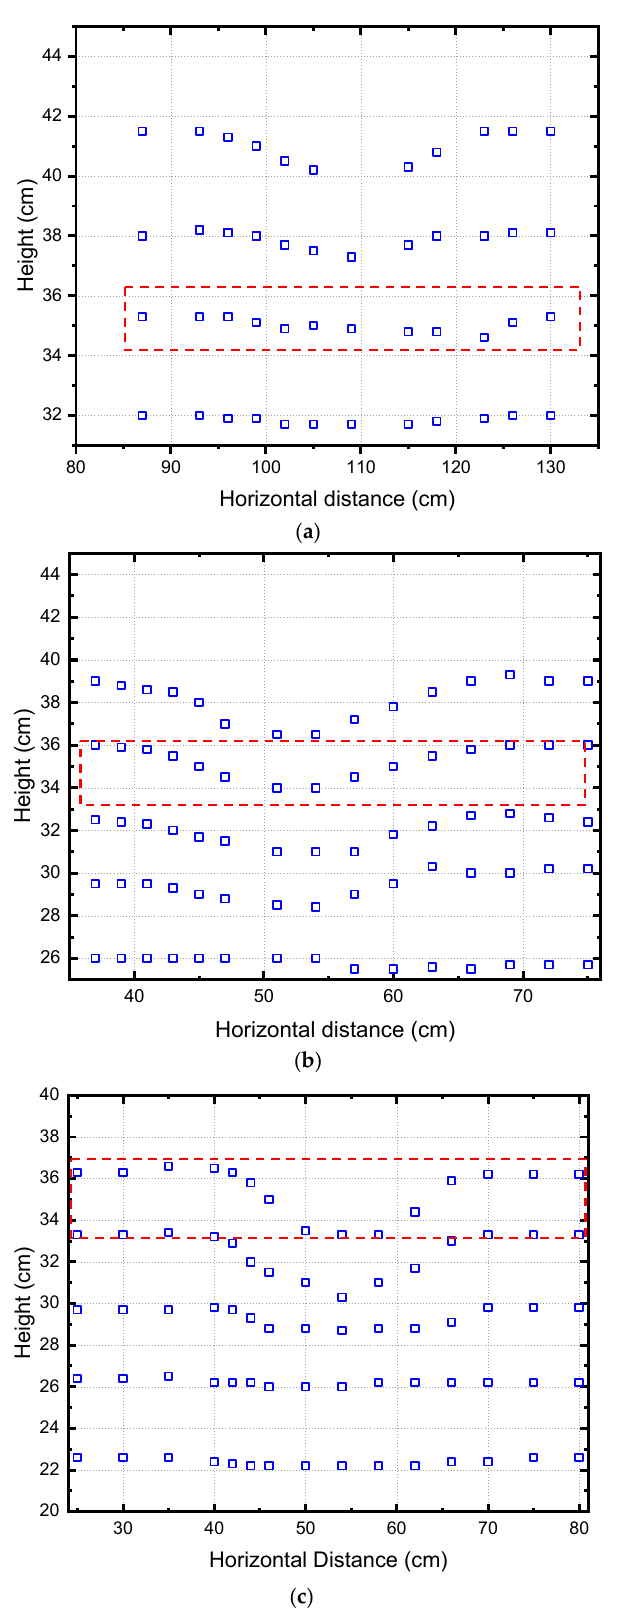
Figure 5. The observed values at different depths in the laboratory tests for ( a ) T1, ( b ) T2, and ( c ) T3.